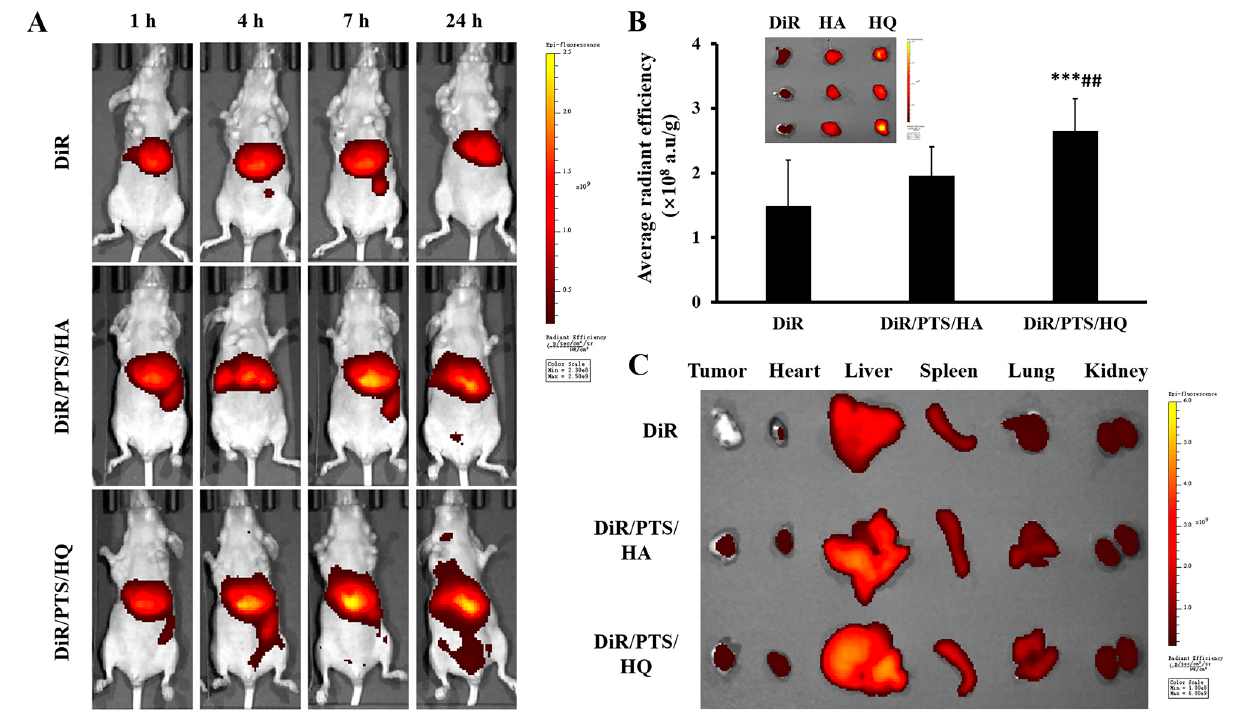
Figure 6. In vivo tumor-targeting evaluation of drug-loaded PTS/HQ PNPs. ( A ) In vivo fluorescence images of DiR suspension, DiR/PTS/HA PNPs, and DiR/PTS/HQ PNPs after tail vein injection into MCF-7/ADR-bearing nude mice for 1, 4, 7, and 24 h. ( B ) Quantitative analysis of the fluorescence intensities of DiR in tumors. Ex vivo images of isolated tumors are also shown in the inset figure. ( C ) Images of isolated tumors and organs at 24 h post-injection. Statistical significance: *** p < 0.005 compared with the free DiR group, ## p < 0.01 compared with the DiR/PTS/HA PNPs group. Data are presented as the mean values ± SD ( n = 3).